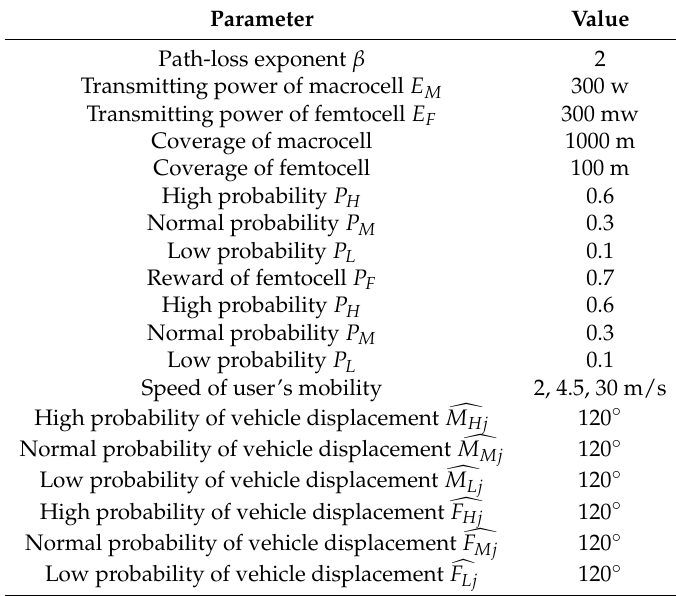
Table 1. Simulation